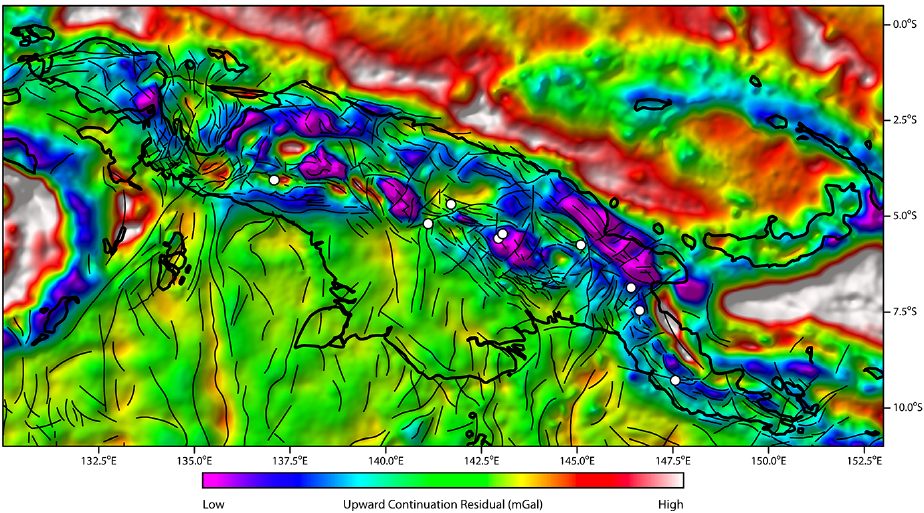
Fig. 10. A new lineament map was generated by interpreting structural features in the free-air, Bouguer and the various UCR filtered gravity data sets. We also compared these interpretations with structural information that was interpreted from the Global Multi-Resolution Topographic data set (Ryan et al., 2009). Here we show the lineament map and the location of major Au/Cu/Ag/Mo deposits draped over the 10km-minus-50km UCR filtered gravity grid (illuminated from the southeast). This figure shows not only that the location of some of the Au/Cu/Ag/Mo deposits (white circles) correlated with identifiable lineaments (transfer faults?), but it also shows that not every deposit is linked with an arc-normal